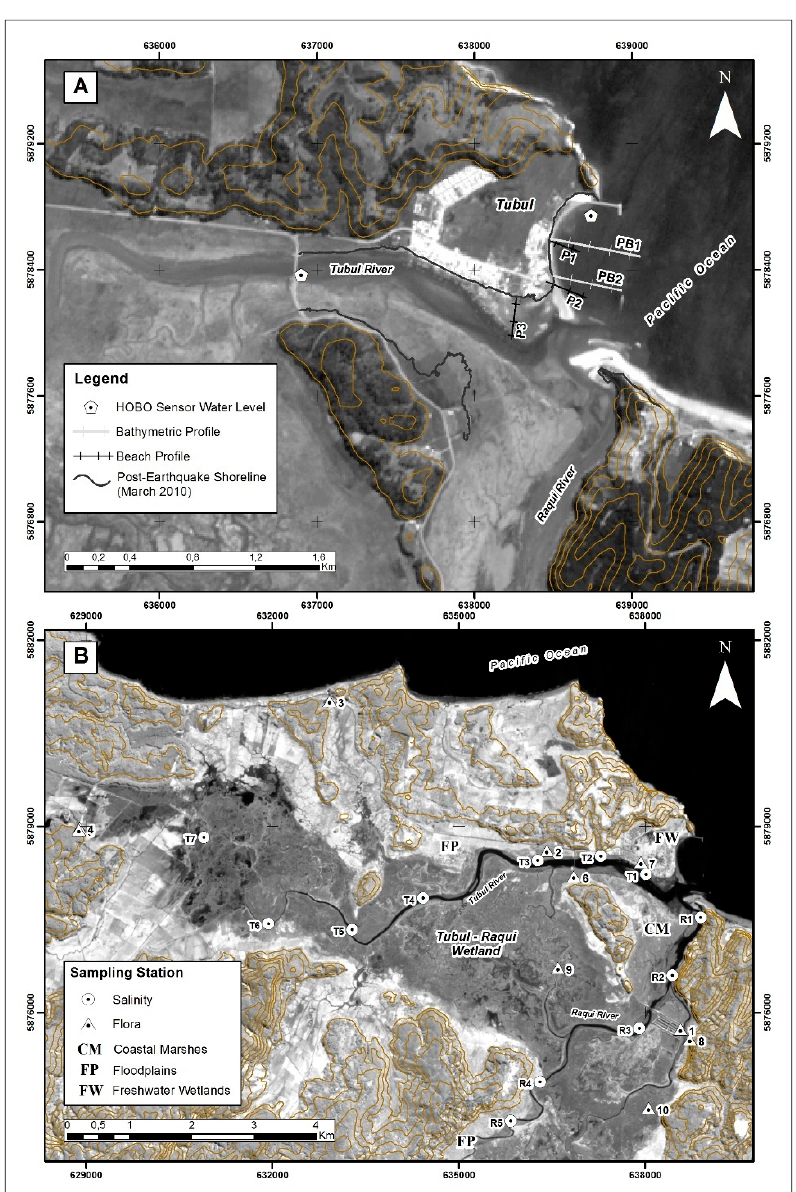
Figure 2. Study area and sampling design: ( A ) indicates the location of the beach and topo-bathymetric profiles, principally within the intertidal zone, an area substantially affected by the coastal uplift from the earthquake of 27 February 2010. The locations of the pressure sensors in the Tubul River and the adjacent marine zone, which were used to obtain tidal records, are also indicated with stars. The changes in the relative shoreline position in two segments of the coastal zone of the wetland are indicated as separate 100 m sections; ( B ) indicates the locations of the salinity and flora sampling stations in the interior of the Tubul (T) and Raqui (R) rivers and the saltmarsh, respectively. Salinity (PSU) measurements were carried out using a multiparameter probe at six stations in the Tubul River and seven stations in the Raqui River.